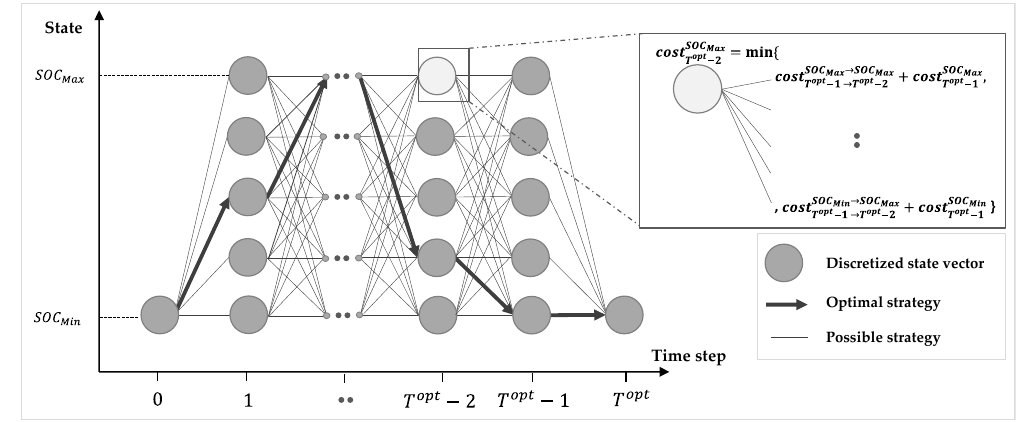
Figure A1. Schematic sketch of the dynamic programming model and an exemplary calculation of the cost of the optimal sub-strategy ( 𝑐𝑜𝑠𝑡 ) for the state SOC Max in the time step T opt − 2